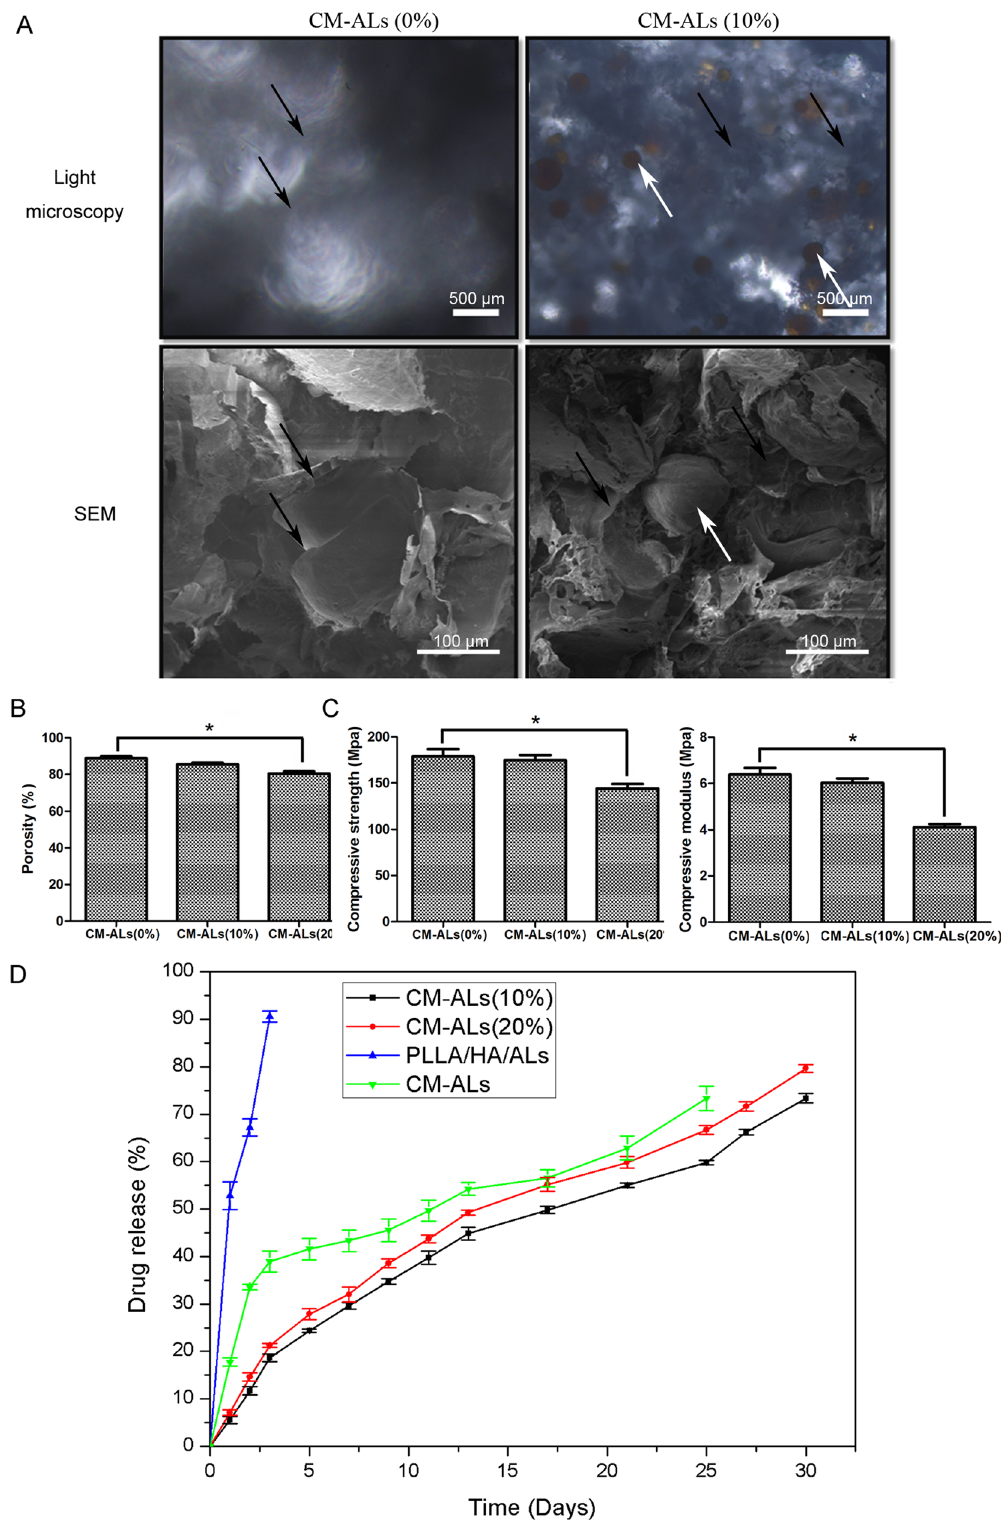
Figure 1. Characteristics of CM-ALs scaffolds containing different concentrations of CH/nHA-AL. ( A ) Morphology of CM-ALs (0%), CM-ALs (10%) and CM-ALs (20%) scaffolds under light microscopy (LM) and scanning electron microscopy (SEM); ( B ) Porosity of CM-ALs scaffolds with different CH/nHA-AL contents; ( C ) Compressive strength and modulus of CM-ALs scaffolds with different CM-ALs contents; ( D ) In vitro drug release assay of CM-ALs scaffolds for a period of up to 25 days using CH/nHA-AL and PLLA/nHA/AL scaffolds as control. Black arrow indicates PLLA/nHA matrix, while white arrow indicates CH/nHA-AL microsphers. * p < 0.05 vs CM-ALs (0%)